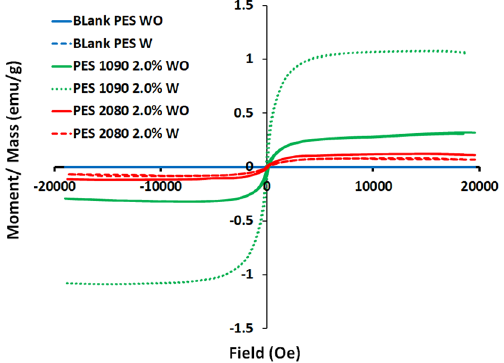
Figure 14. The M-H hysteresis loops of the bank PES and the magnetic mixed matrix PES membranes (PES 1090 2.0% and PES 2080 2.0% without and with using 0.1 wt% of Lithium chloride additive in the membranes dopes.